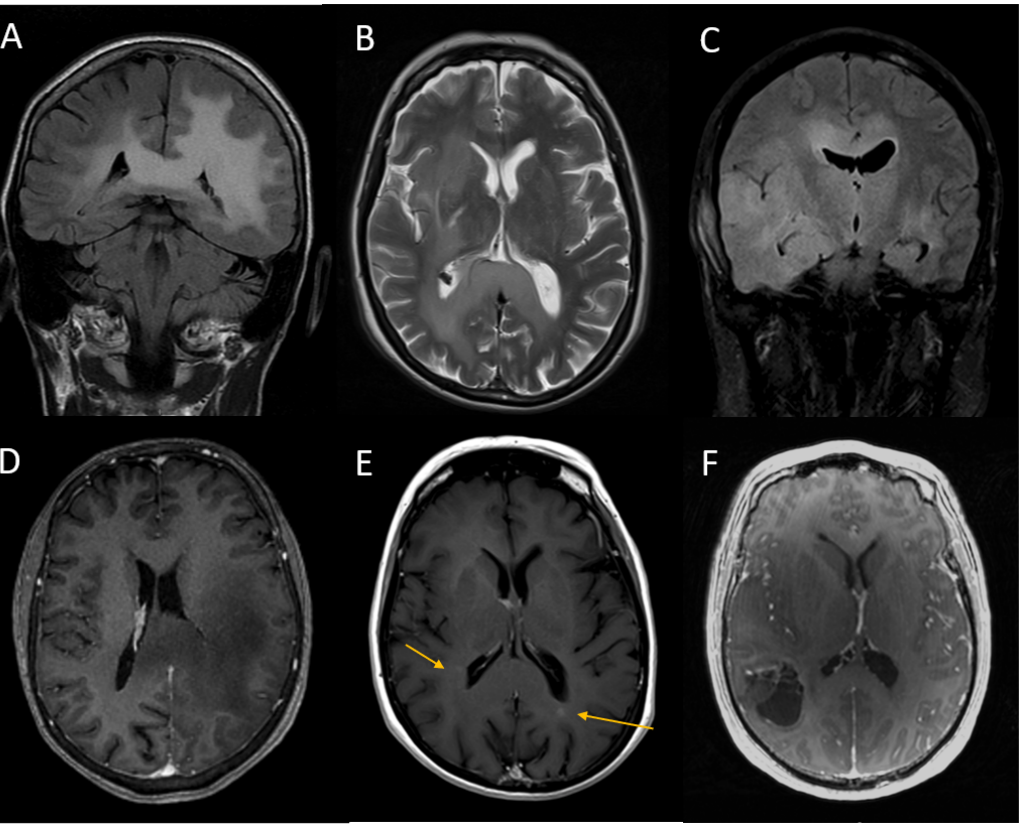
Figure 1. Fluid-attenuated inversion recovery (FLAIR, ( A , C )), T2-weighted ( B ) and gadolinium-enhanced T1-weighted images ( D – F ) in three individuals with gliomatosis demonstrating non-enhancing ( D ), patchy solid enhancing (( E ), arrows) and rim-enhancing ( F ) infiltration. The median ADC mean value within tumour was 0.97 × 10 − 3 mm 2 /s (IQR 0.87 to 1.10), Table 2. Imaging features on the first available MRI examination. while the median ADC of normal white matter elsewhere was 0.75 × 10 − 3 mm 2 /s (IQR 0.73 to 0.82). The ADC min value within each tumour was also measured, with a median of 0.81